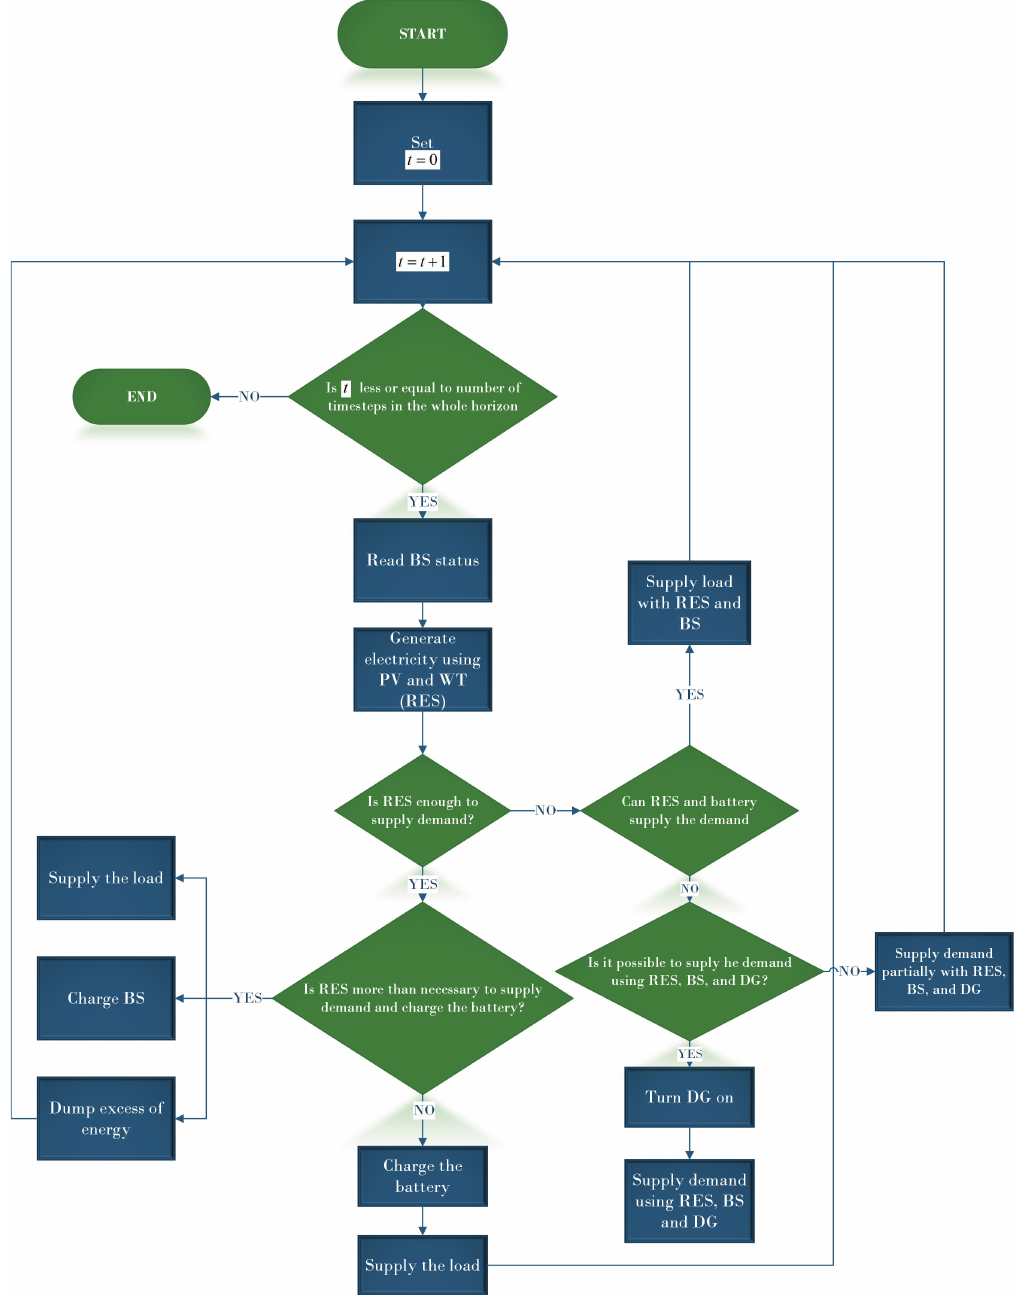
Figure 20. Flow diagram for the HRES management